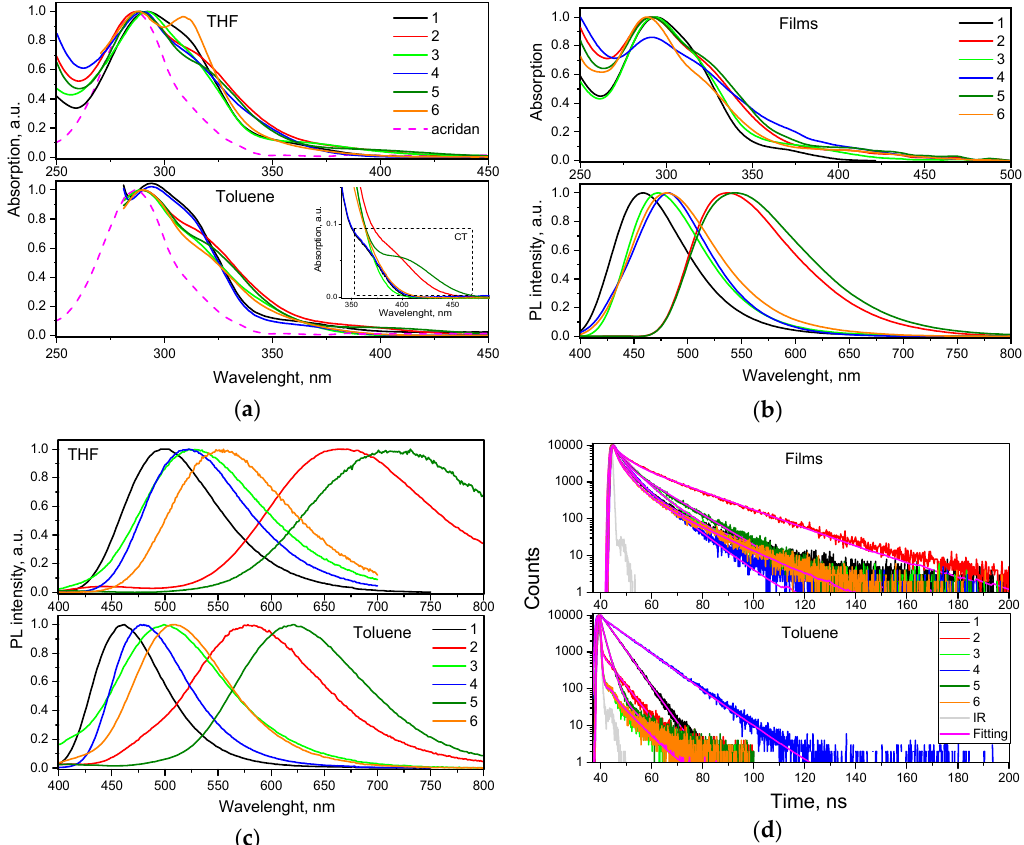
Figure 4. ( a ) UV ‐ vis absorption spectra of THF and toluene solutions of compounds 1 – 6 in (10 − 5 M). The low ‐ energy ICT absorption bands of the solutions in toluene are zoomed in the inset. ( b ) UV ‐ vis absorption and PL spectra of the films of 1 – 6 . ( c ) Steady ‐ state PL spectra of THF and toluene solutions of compounds 1 – 6 . ( d ) PL decays of solid samples and toluene solutions of 1 – 6 recorded at excitation wavelength 374